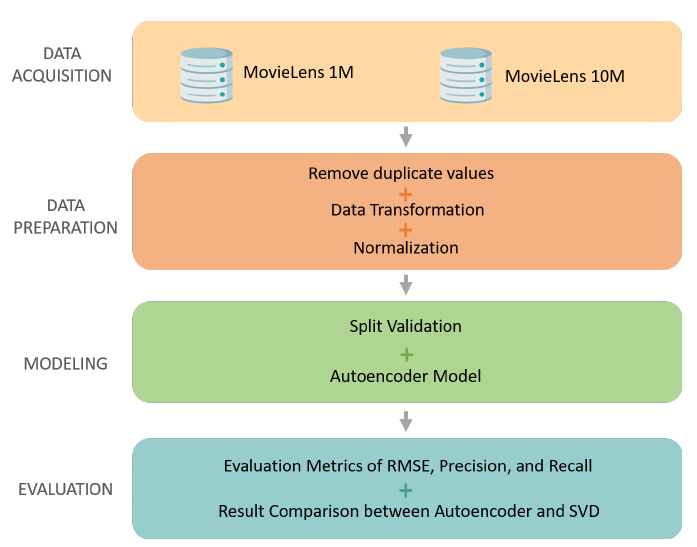
Figure 3. Project plan of the